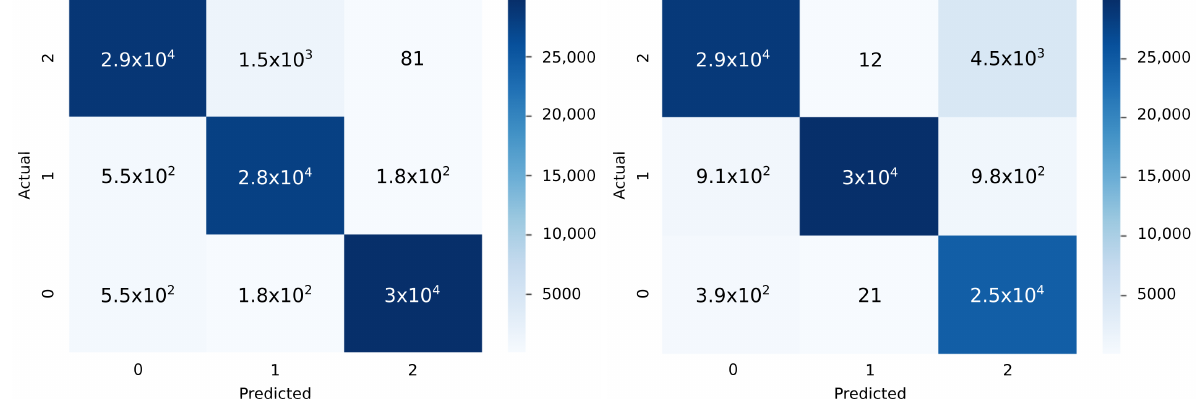
Figure 16. Confusion matrices. Comparison: Neural network (left), FIR (right). 0: Electrons, 1: muons, 2: electrical